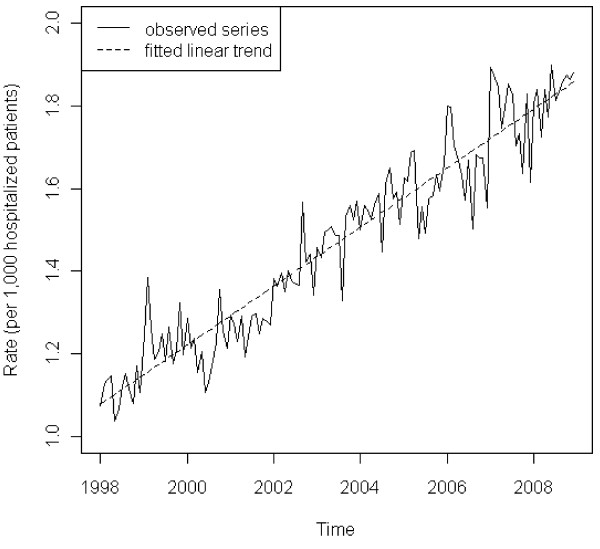
Monthly incidence rates of hospitalizations among patients with sarcoidosis (Nationwide Inpatient Sample, 1998–2008). The solid line represents the observed rate over time. The dashed line is the fitted linear trend (p < 0.0001)